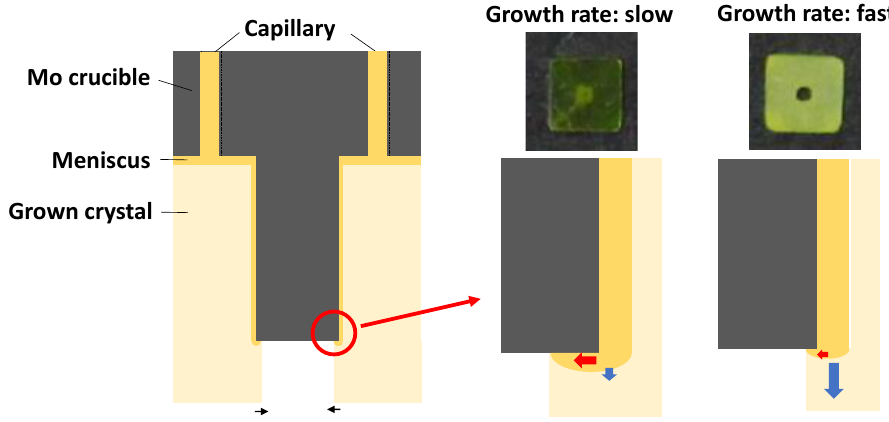
Figure 4. Schematic diagram of effect of growth speed on control of internal crystal diameter. Middle: At a slow growth rate (0.2 mm/min), the meniscus was wetted and spread at the tip of the protrusion, and the inside of the tube crystal was filled with melt. Right: At high growth rates (0.5 mm/min), the inside of the tube crystal was not filled with melt because the wetting spread of the meniscus to the tip of the protrusion was suppressed.